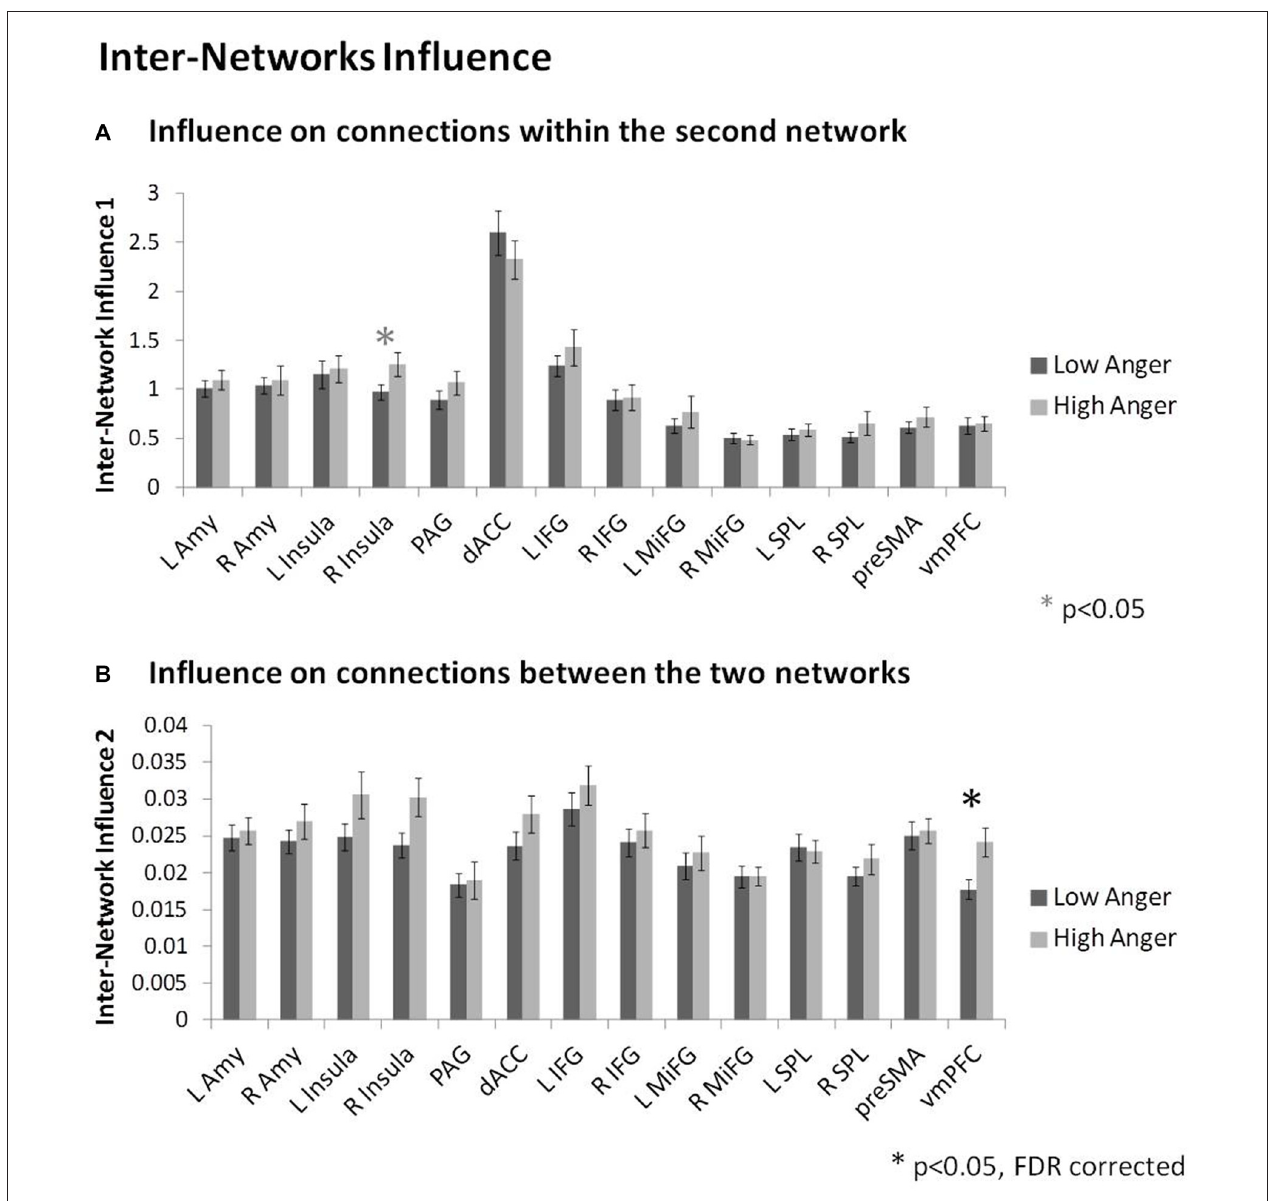
FIGURE 5 | Inter-Network network results. The nodes’ inter-network influencing degree averaged over all 74 subjects for the influence on connections within the second network (A) , and the influence on connections between the two networks (B) . The vmPFC influence on the connections between the reactivity network and the regulation network was significantly higher in the high anger condition vs. low